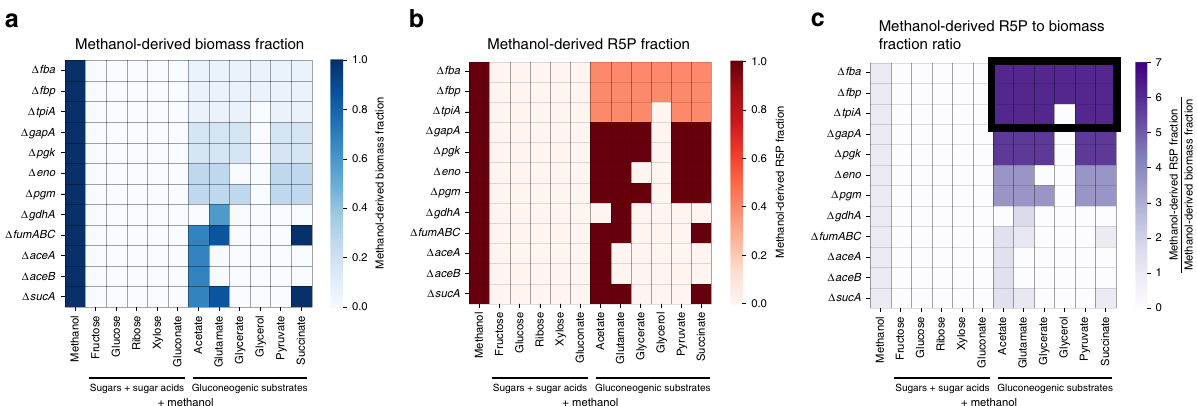
Fig. 2 In silico validation of methanol-dependent strains. Methanol-dependent strains with gene deletions representing a single reaction knockout in FBA are shown. a The methanol-derived biomass fractions for predicted methanol-dependent strains growing on methanol with or without a sugar/sugar acid co-substrate, or a gluconeogenic co-substrate. The methanol-derived biomass fraction ranges from 0.0 (the biomass is methanol-independent) to 1.0 (the biomass fully depends on methanol). b The methanol-derived R5P fractions for predicted methanol-dependent strains. It ranges from 0.0 (completely independent) to 1.0 (completely dependent). c The ratio of the methanol-derived R5P fraction to the one of the biomass is used to compare the predicted methanol-dependent strains. The higher the ratio, the more promising the experimental implementation of the strain with an operational RuMP cycle (the top strains and conditions are highlighted by a black box). Source data are provided as a Source Data fi